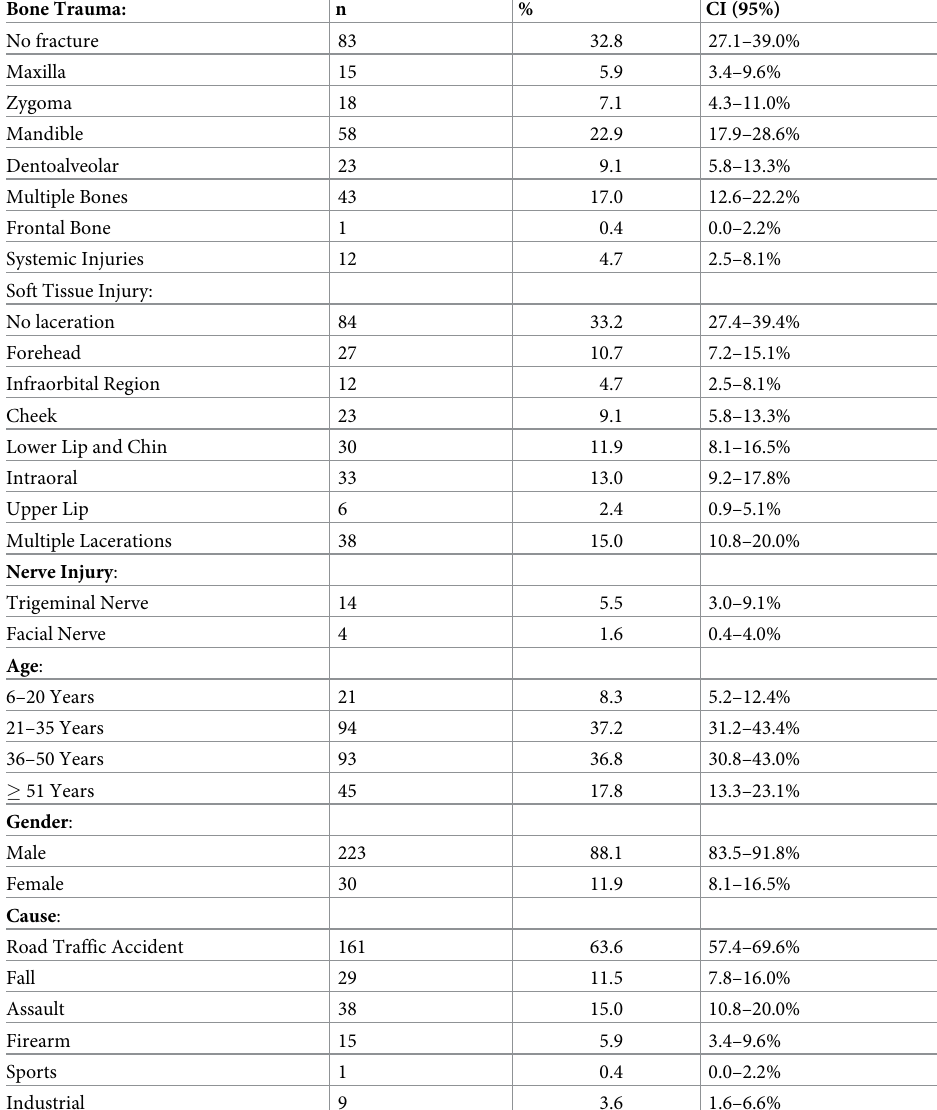
Table 1. Univariate analysis of predictors and outcome